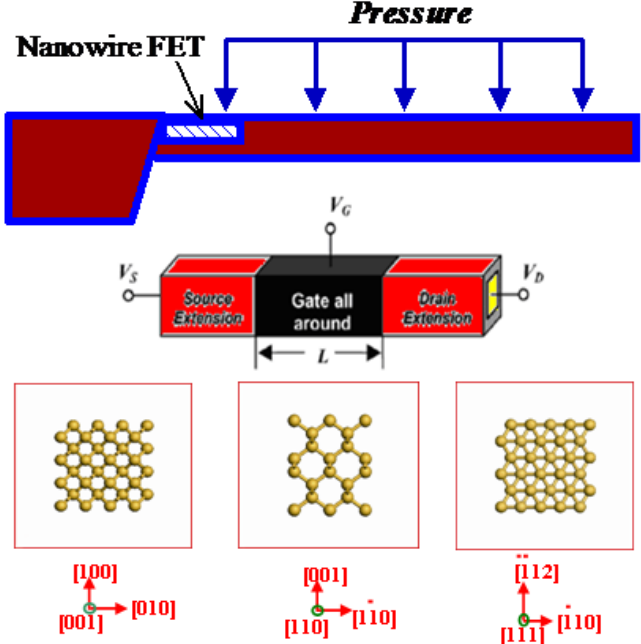
Figure 1. A schematic diagram of the SiNW FET pressure sensor. In this work, the